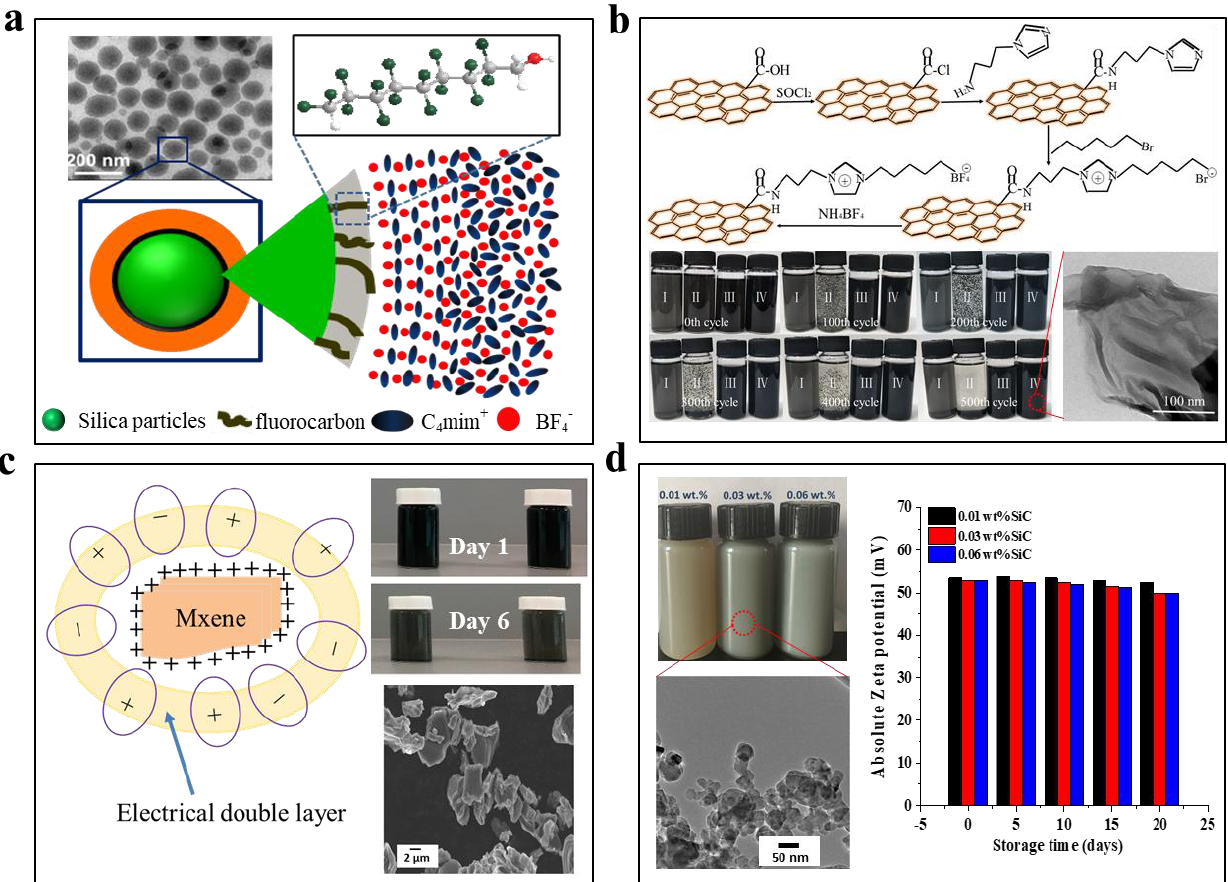
Figure 6. ( a ) Surface modification of SiO 2 nanoparticles with fluorocarbon brushes to create steric hinderance stabilization and enable their stable dispersion within [C 4 mim]BF 4 ionic fluids (( a ) reprinted/adapted with permission from Ref. [108]. 2015, the American Chemical Society). ( b ) Surface modification of graphene by grafting the molecular chains similar to [HMIM]BF 4 iconic fluids enable stable dispersion of the resultant nanofluids under medium temperatures and cycled heating/cooling conditions (( b ) reprinted/adapted with permission from Ref. [109]. 2017, Elsevier). ( c ) Homogenous dispersion of MXene (Ti 3 C 2 ) within [EMIM][OSO 4 ] and diethylene glycol (( c ) reprinted/adapted with permission from Ref. [111]. 2020, Multidisciplinary Digital Publishing Institute). ( d ) Electrostatically stablized SiC nanoparticles within [HMIM]BF 4 ionic fluids (( d ) reprinted/adapted with permission from Ref. [112]. 2017, Elsevier).